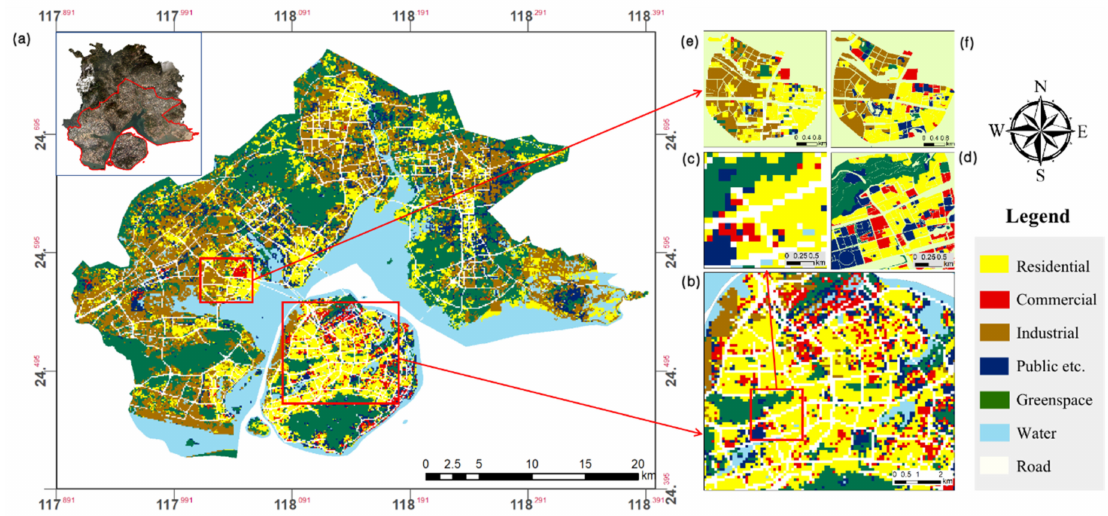
Figure 18. ( a ) Land use grid-based urban area map of Xiamen; ( b ) zoomed-in area of the right red frame in graph ( a ); ( c ) zoomed-in area of the red frame in graph ( b ); ( d ) parcel-based map for the same area of graph ( c ); ( e ) zoomed-in area of the left red frame in graph ( a ); ( f ) parcel-based map for the same area of graph ( e ).